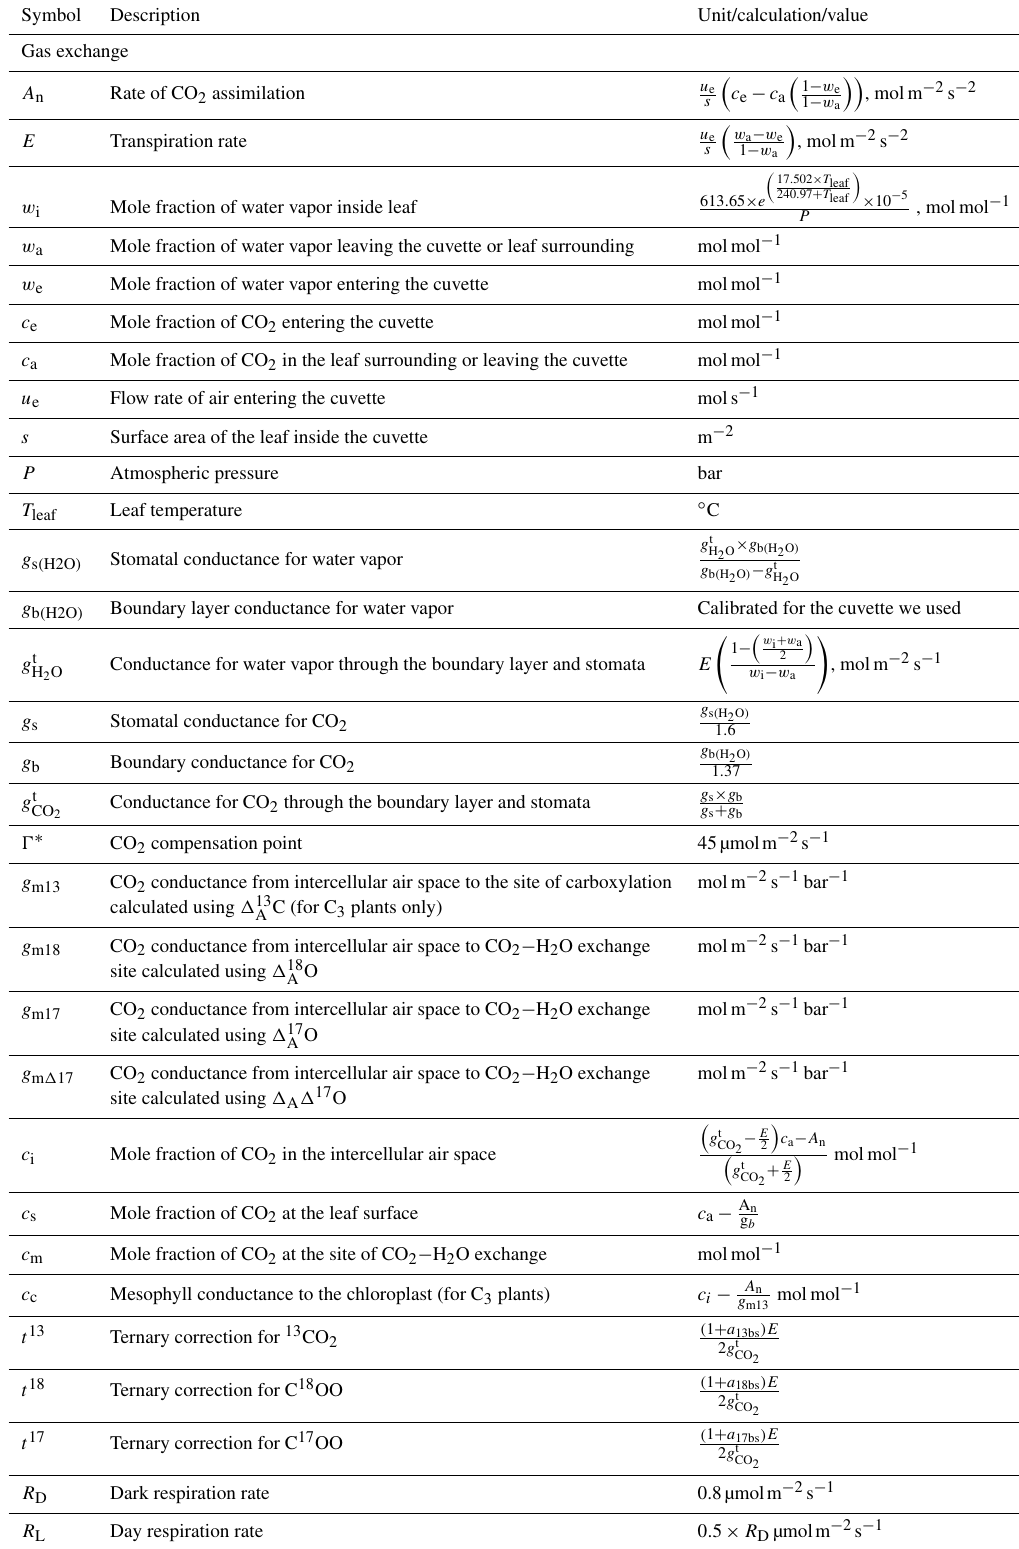
Table 2. List of symbols and